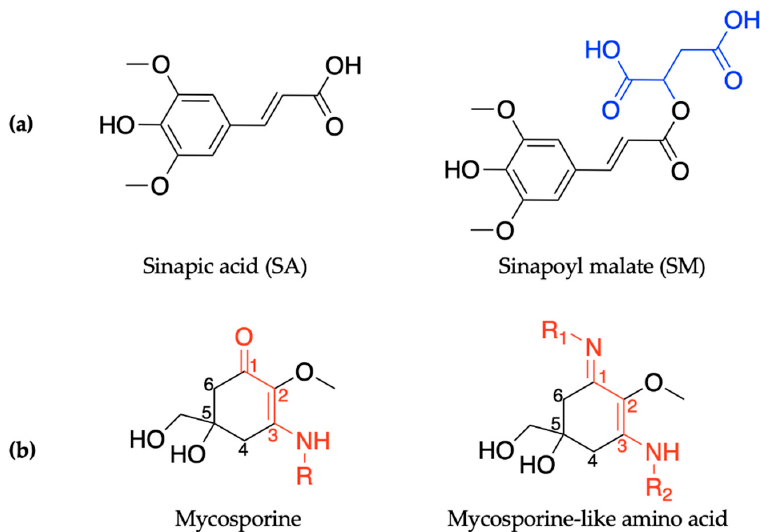
Figure 1. Chemical structures of ultraviolet (UV) filters found in nature including ( a ) the plant-based sinapic acid (SA) and sinapoyl malate (SM), with the malate group added to the sinapic acid shown in blue; and ( b ) the core components of mycosporines and mycosporine-like amino acids synthesized by microorganisms, with the chromophores shown in red. See main text for definitions of R/R 1 /R 2 . Stereocenters have not been included in the structures.